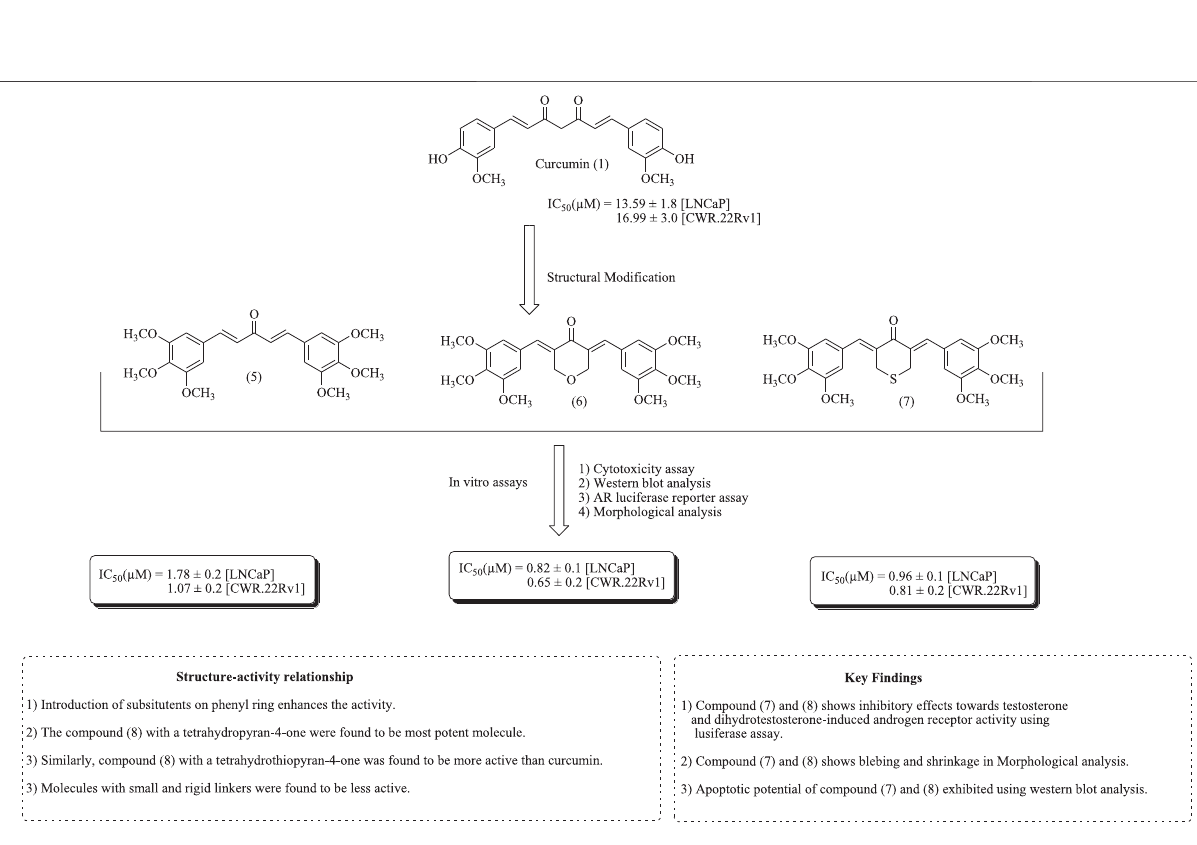
Frontiers in Pharmacology |